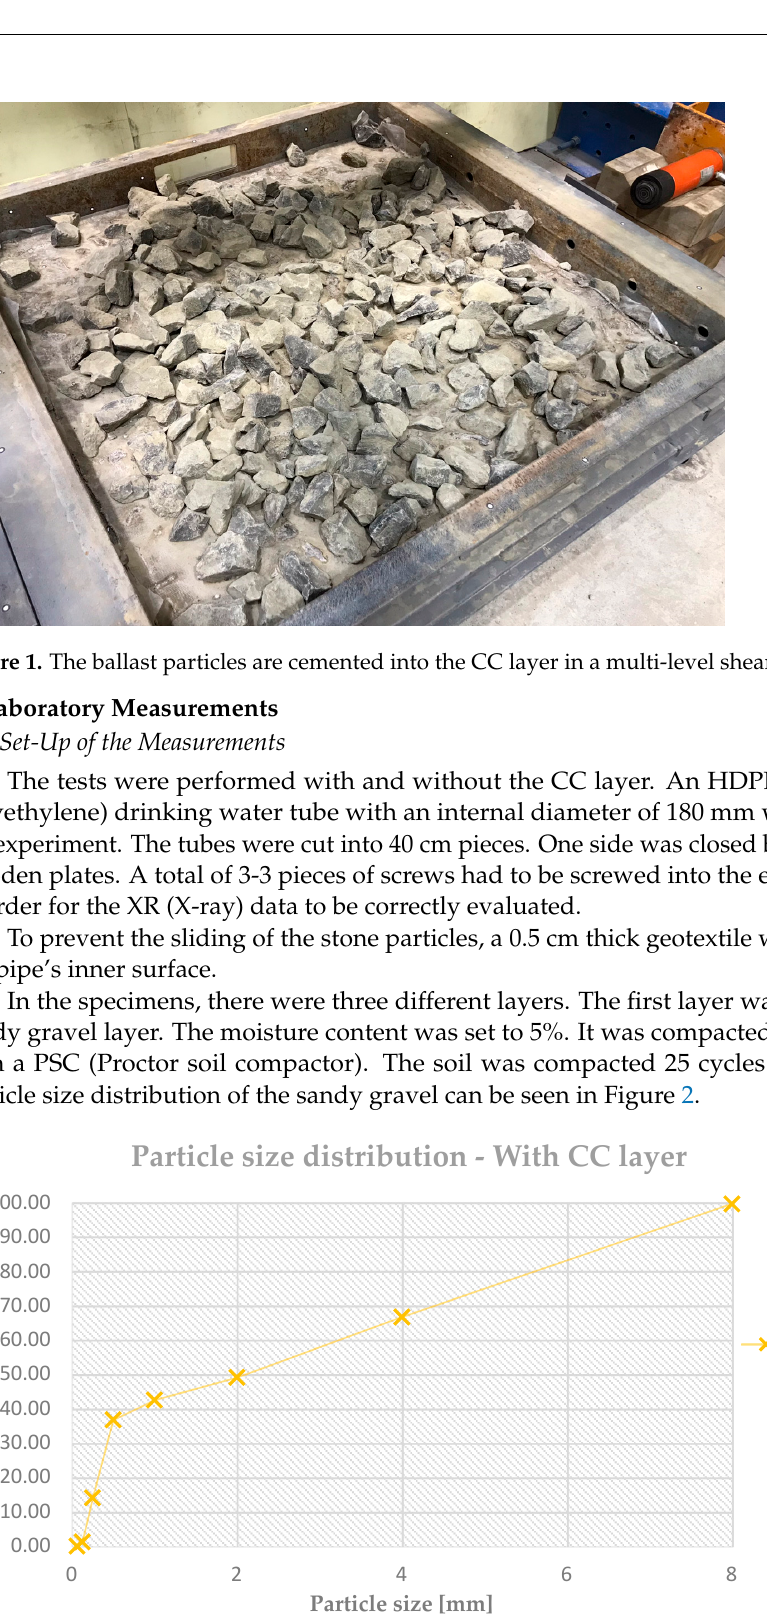
Figure 2. Establishment of the inner surface and the prepared specimen without ballast particles (PSD—particle size distribution).